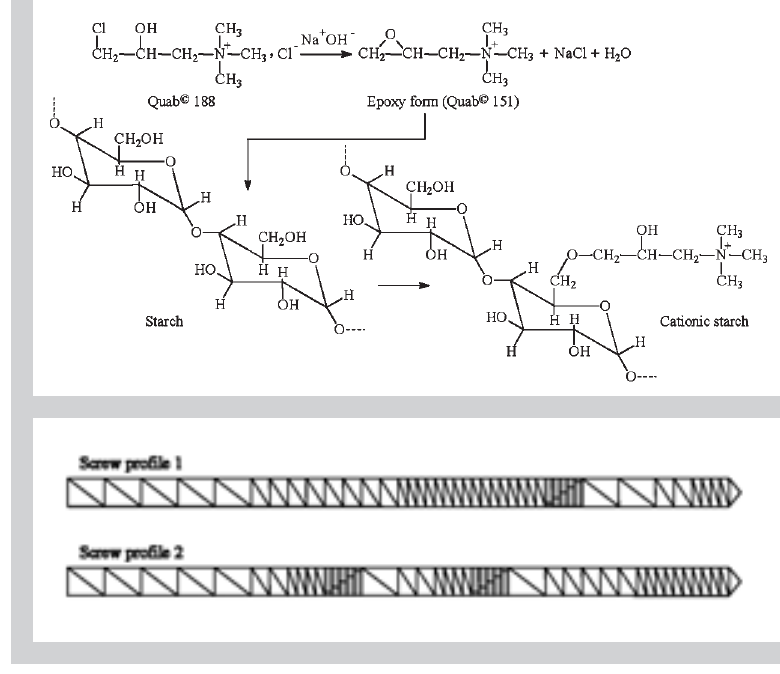
Figure 1 (above): Reaction scheme of starch cationization. Figure 2: Screw profiles used in the study (Clextral